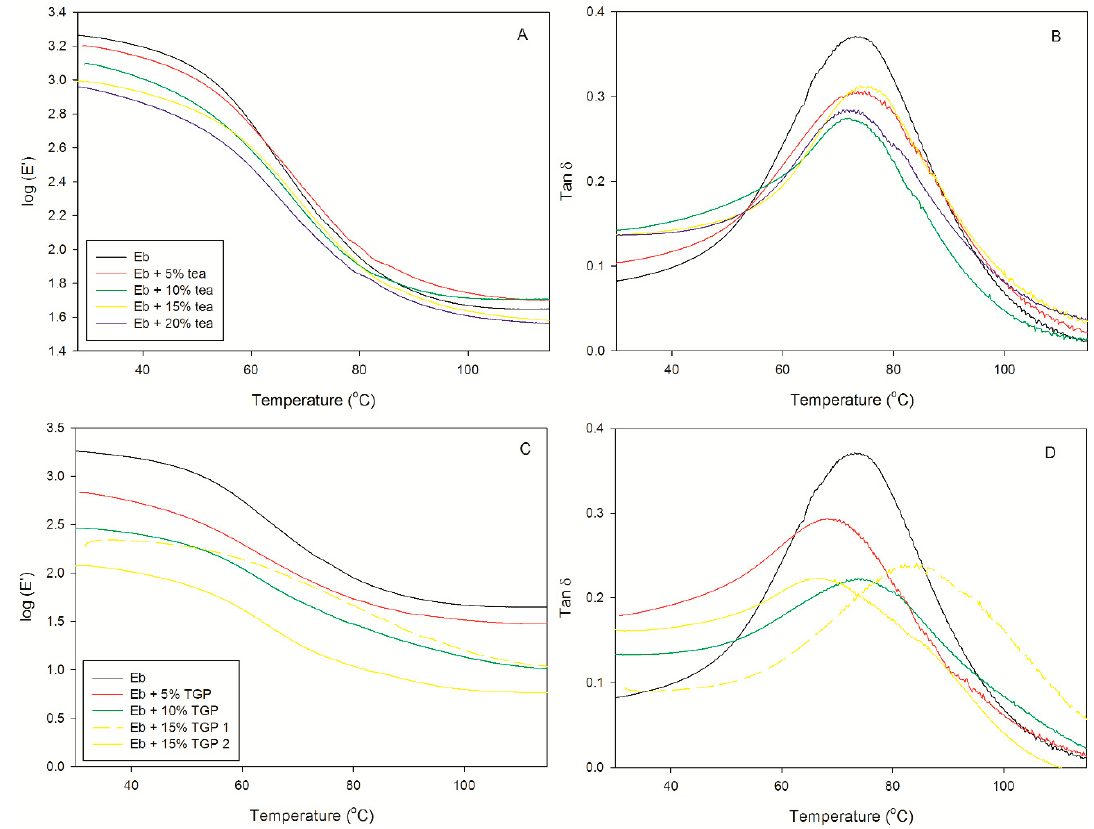
Figure 6. ( A ) Storage modulus and ( B ) tan δ (loss tangent = E” / E’) of tea films and ( C ) the storage modulus and ( D ) tan δ (loss tangent = E” / E’) of TGP films.